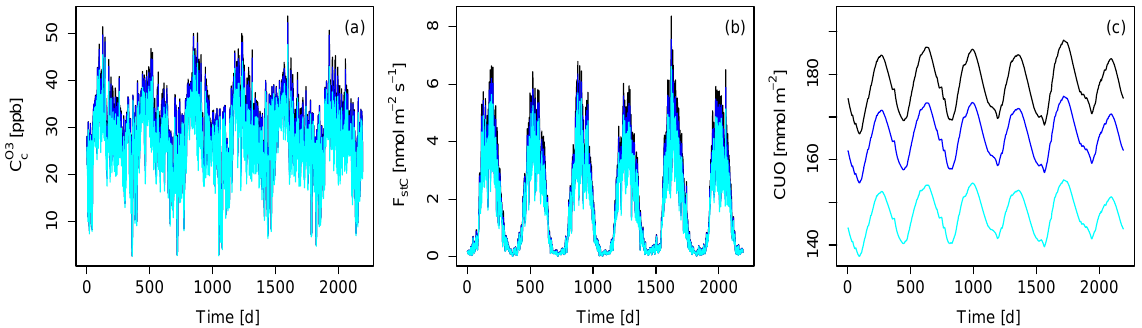
Figure 8. Mean daily values of the (a) O 3 surface concentration (ppb), (b) canopy-integrated O 3 uptake into the leaves (nmolm − 2 s − 1 ), and (c) canopy-integrated cumulative uptake of O 3 (CUO) (mmolm − 2 ) at the FLUXNET site FI-Hyy. Black: ATM model; dark blue: D-STO model; light blue: standard deposition model